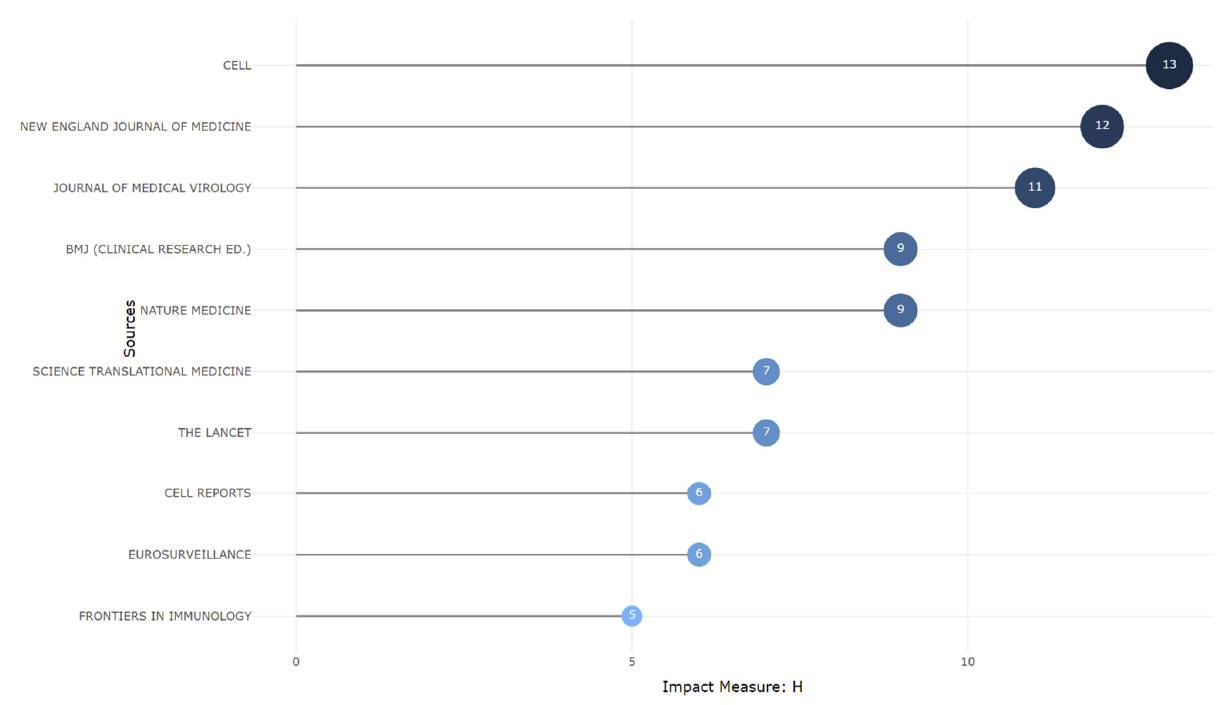
Figure 4. Top ten highly cited journals based on Omicron variant research.